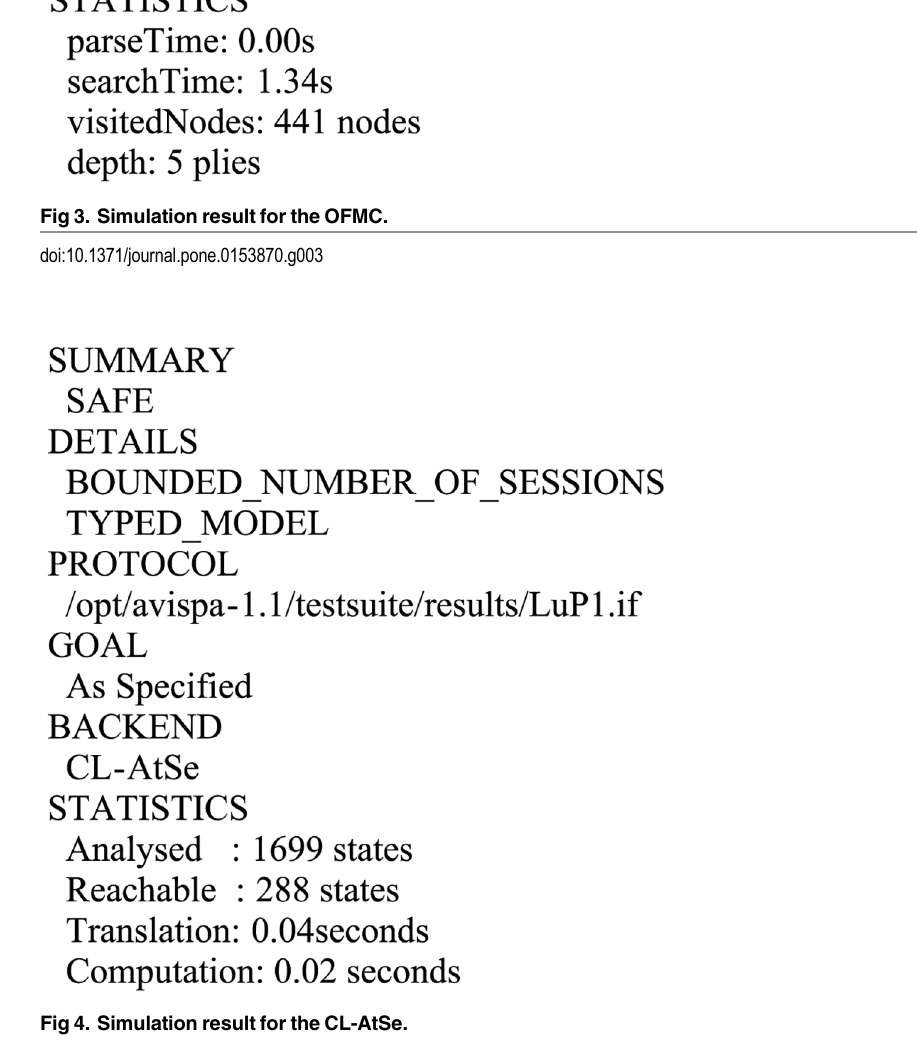
Fig 4. Simulation result for the